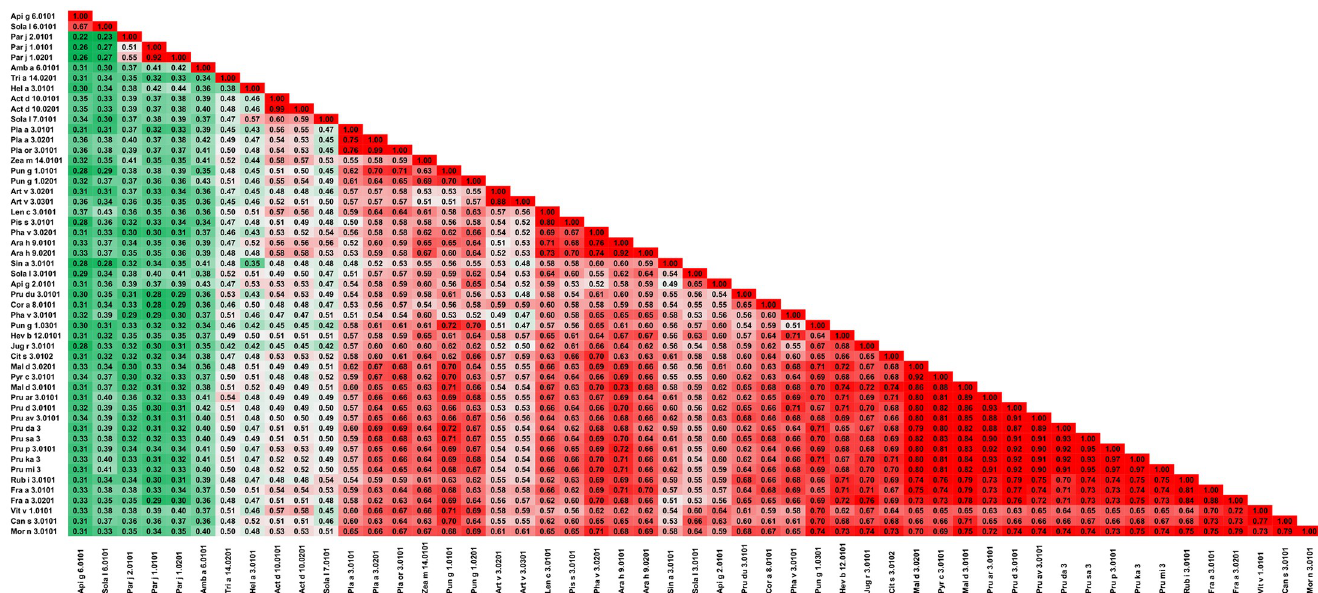
Fig 21. Plot showing A-RISC index values for allergen pairs from nsLTP family. Red color indicates a high risk of cross-reactivity, a dark green color indicates a low risk of cross-reactivity, and intermediate colors correspond to a medium risk of cross-reactivity.